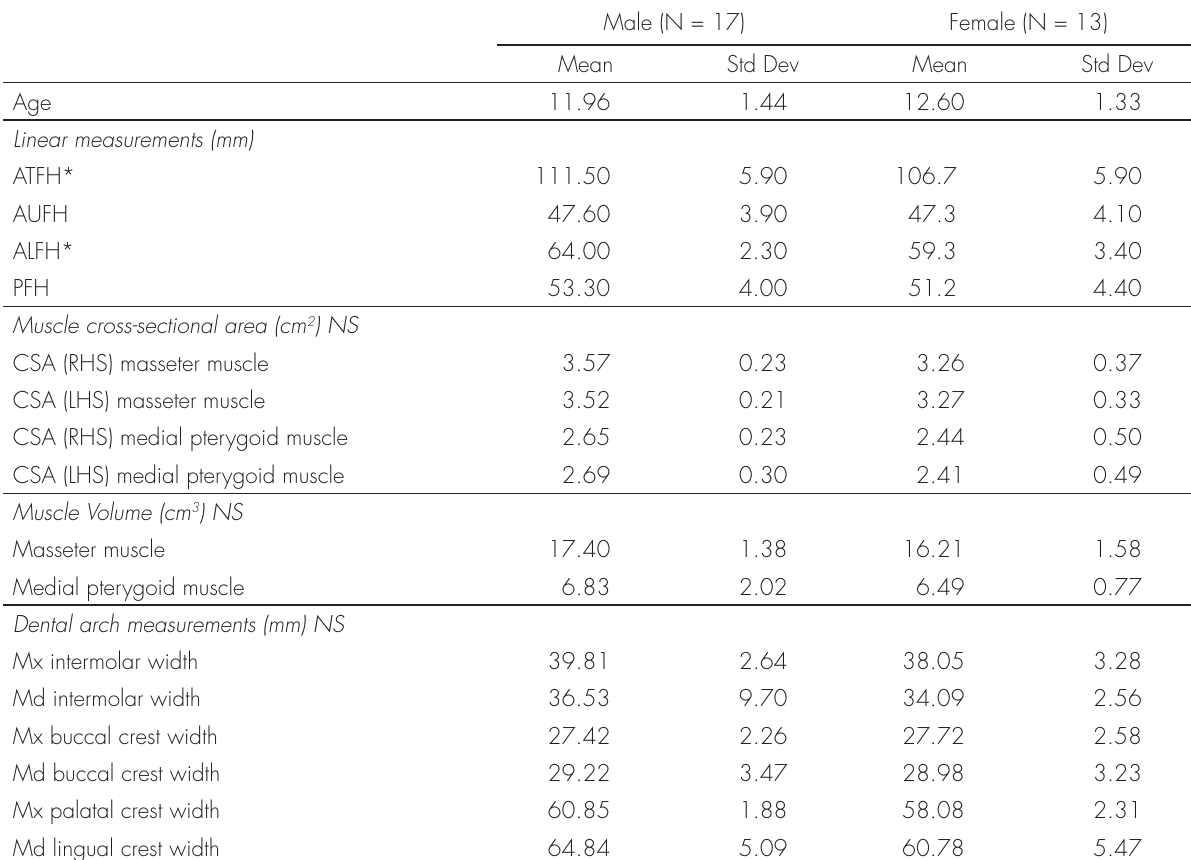
Table VI. Means for various measurements in male and female